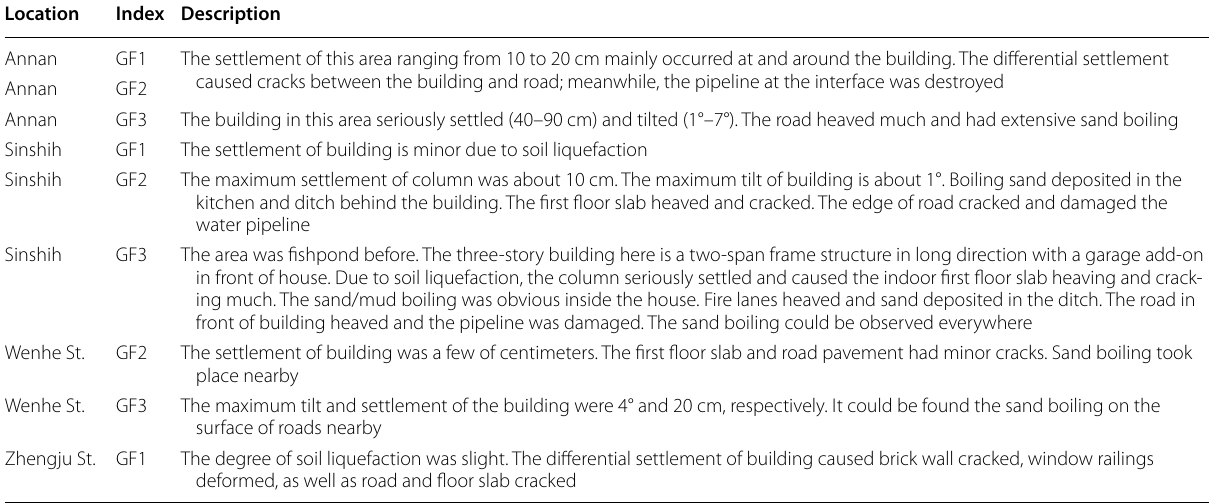
Table 2 Damage description of major liquefaction